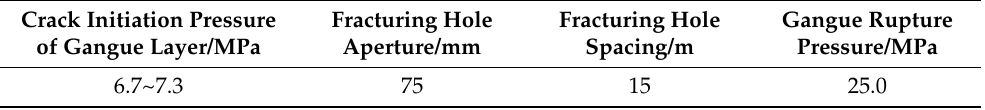
Table 2. Determination of parameters related to hydraulic fracturing. Crack Initiation Pressure of Gangue Layer/MPa